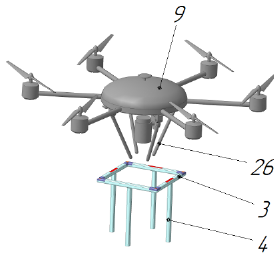
Figure 28. Automatic station for charging and maintenance of a multi-rotor UAV and a UAV working for it [79]. 3, landing ring; 4, landing ring supports; 9, UAV; 26, UAV